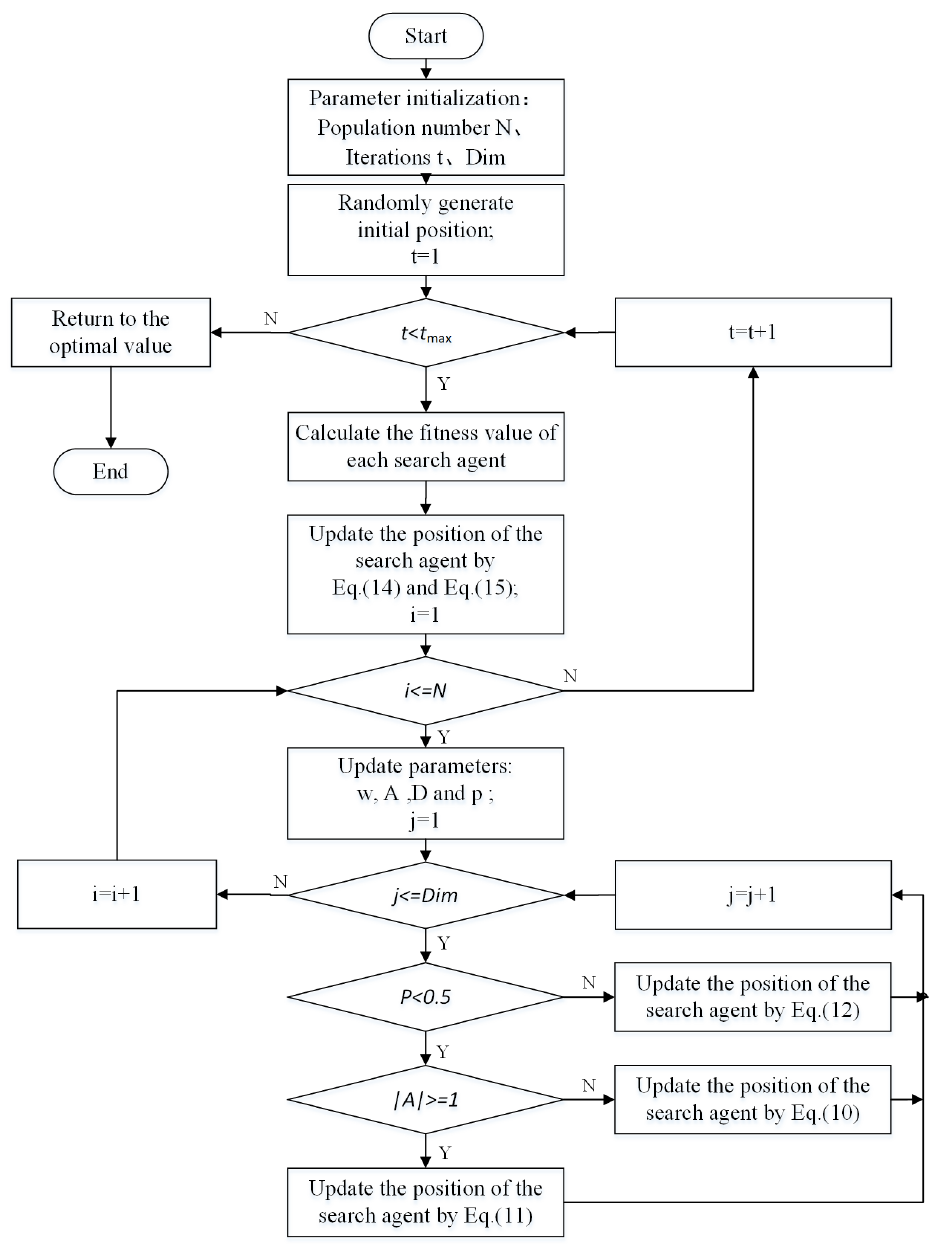
Figure 3. The flowchart of IWOA. The pseudo code of IWOA is shown in Algorithm